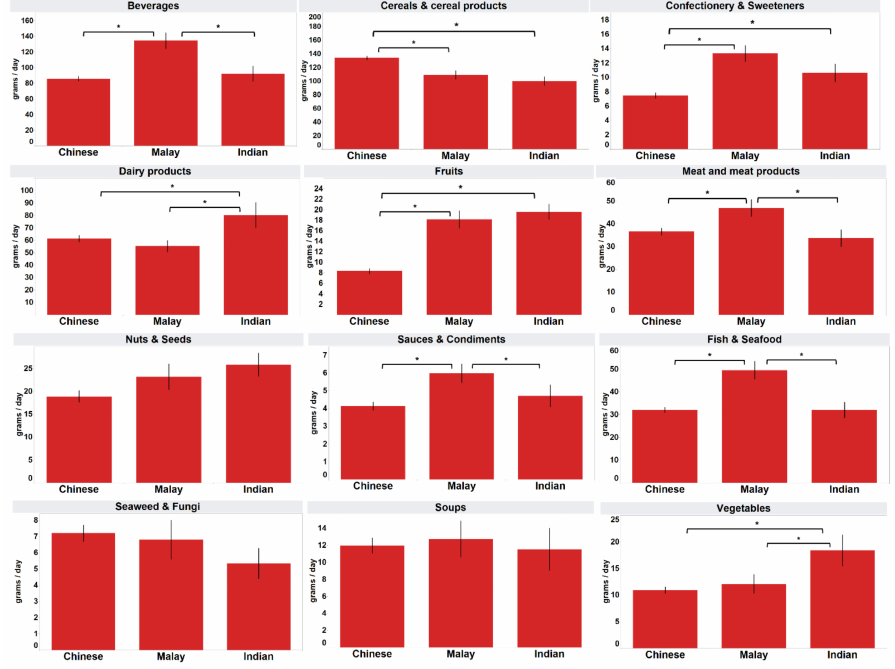
Figure 1. Mean daily intake of the consumers, considering the top three ethnic groups. * Mean values were significantly different as determined by ANOVA with Tukey’s HSD test for multiple comparisons ( p <